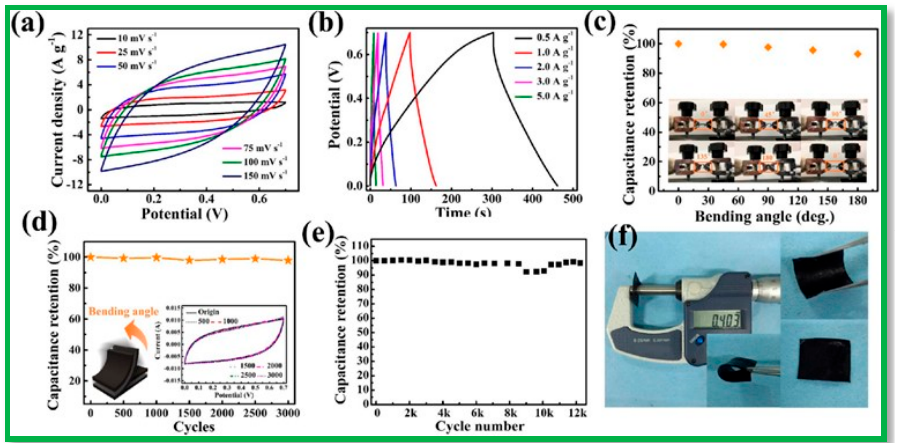
Figure 12. ( a ) CVs and ( b ) GCDs of as-prepared flexible solid-state device obtained at different scan rates and current densities. ( c ) Performance stability of flexible SC under different bending angles. ( d ) Capacitance stability of flexible SC device under bending test, and ( e ) flexible SC cycling stability of 10,000 charging/discharging cycles at 3 A g − 1 . ( f ) Digital photographs of flexible device and its thickness (~400 µm). Reprinted (adapted) with permission from ACS Applied Materials and Interfaces [120], Copyright 2018 American Chemical Society.